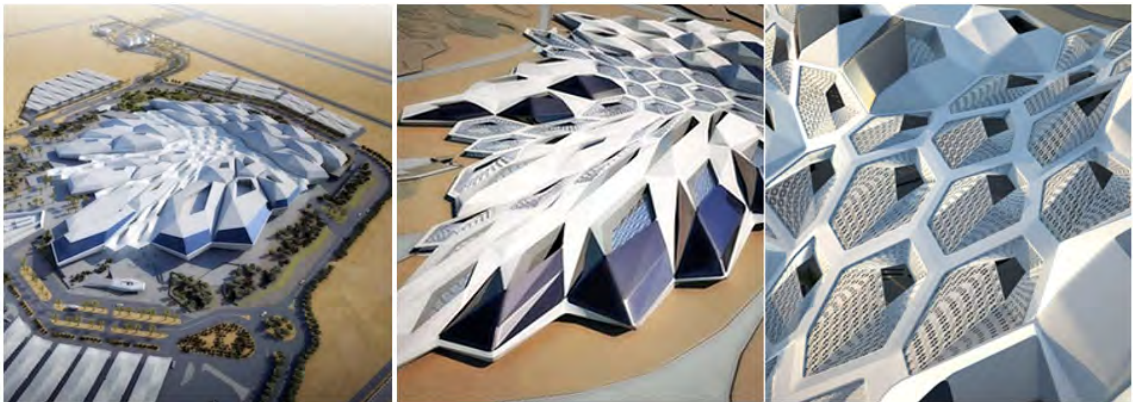
Figure 9. The fractal cells at King Abdullah Petroleum studies & research